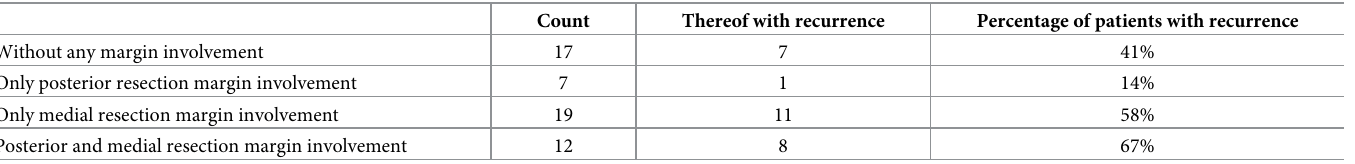
Table 4. Amount of recurrences as a function of margin involvement � .